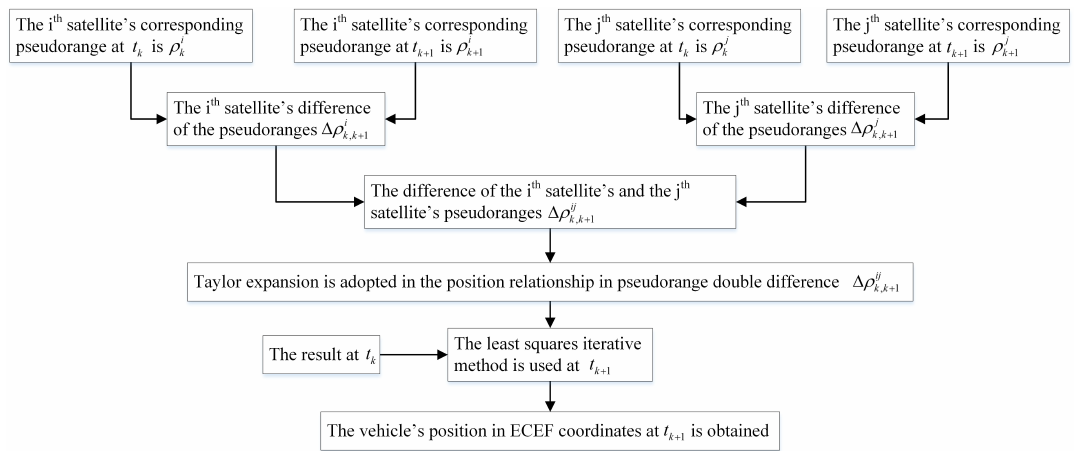
Figure 3. Pseudorange double-difference model establishment and solution.